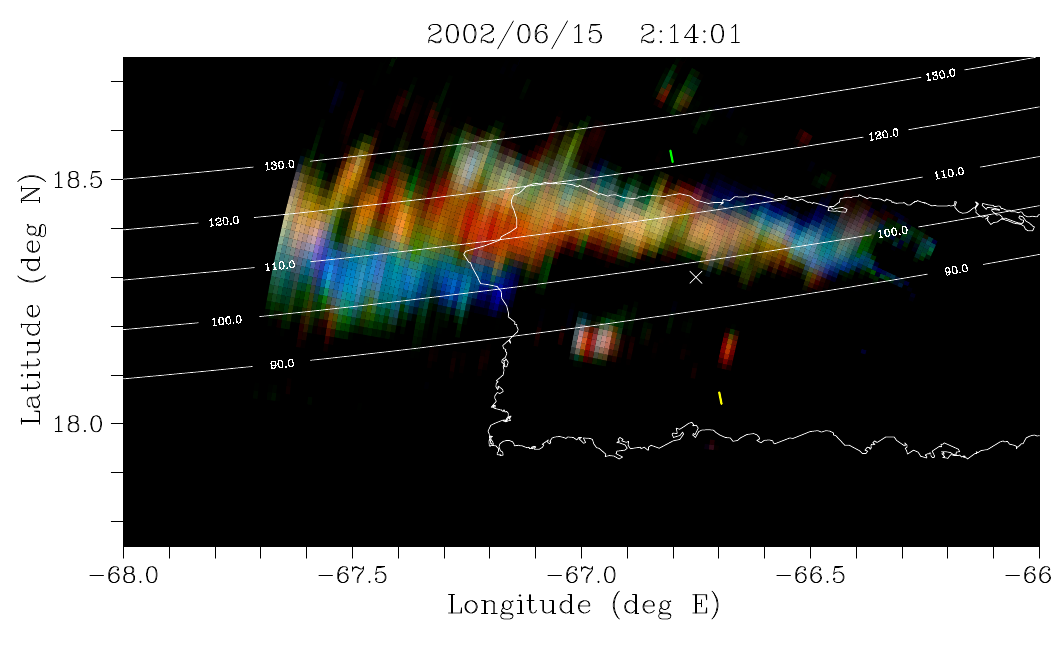
Fig. 12. Radar image of coherent echoes received at 02:14UT.